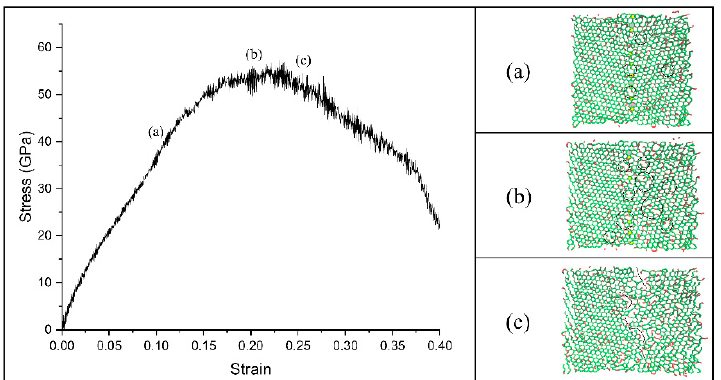
Figure 6. Tensile stress-strain curve and dynamic fracture process of PGO under the strain rate of 1 × 10 − 5 fs − 1 . ( a ) PGO at strain of 0.14; ( b ) PGO at strain of 0.26; ( c ) PGO at strain of 0.36.